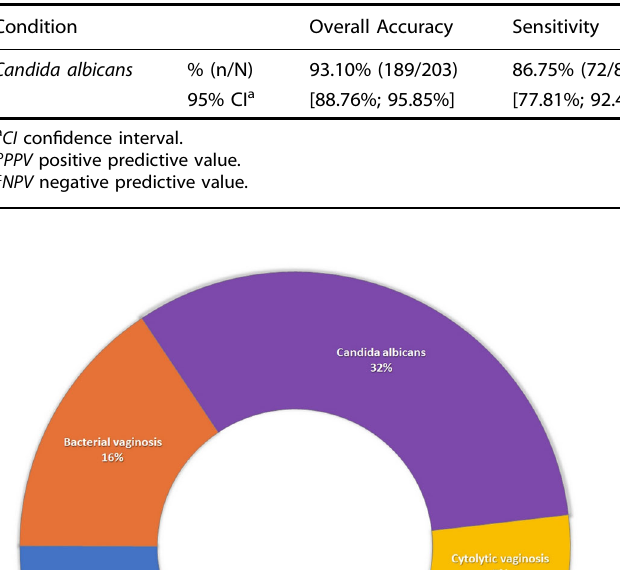
Table 2. Diagnostic performance of physician diagnosis compared to lab culture for Candidiasis.